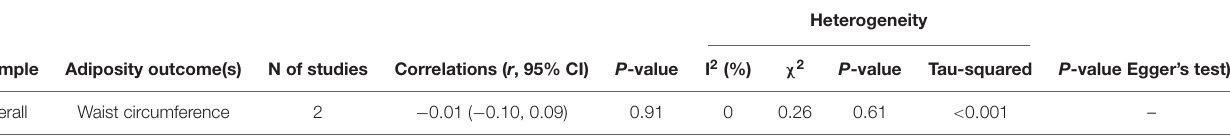
TABLE 4 | Overall meta-analysis of the correlations ( r , 95% CI) between serum cortisol concentration and waist circumference among children based on cross-sectional studies.